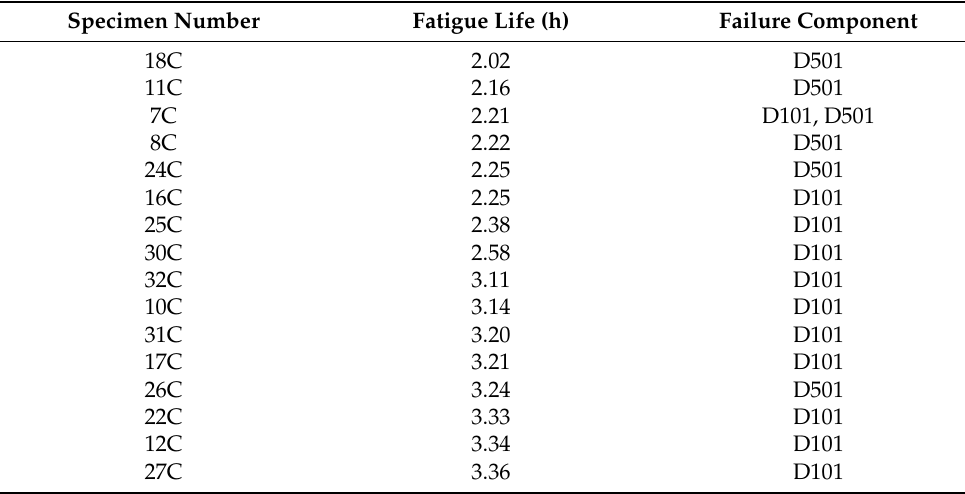
Table 12. Test results for combined temperature cycling and random vibration. Specimen